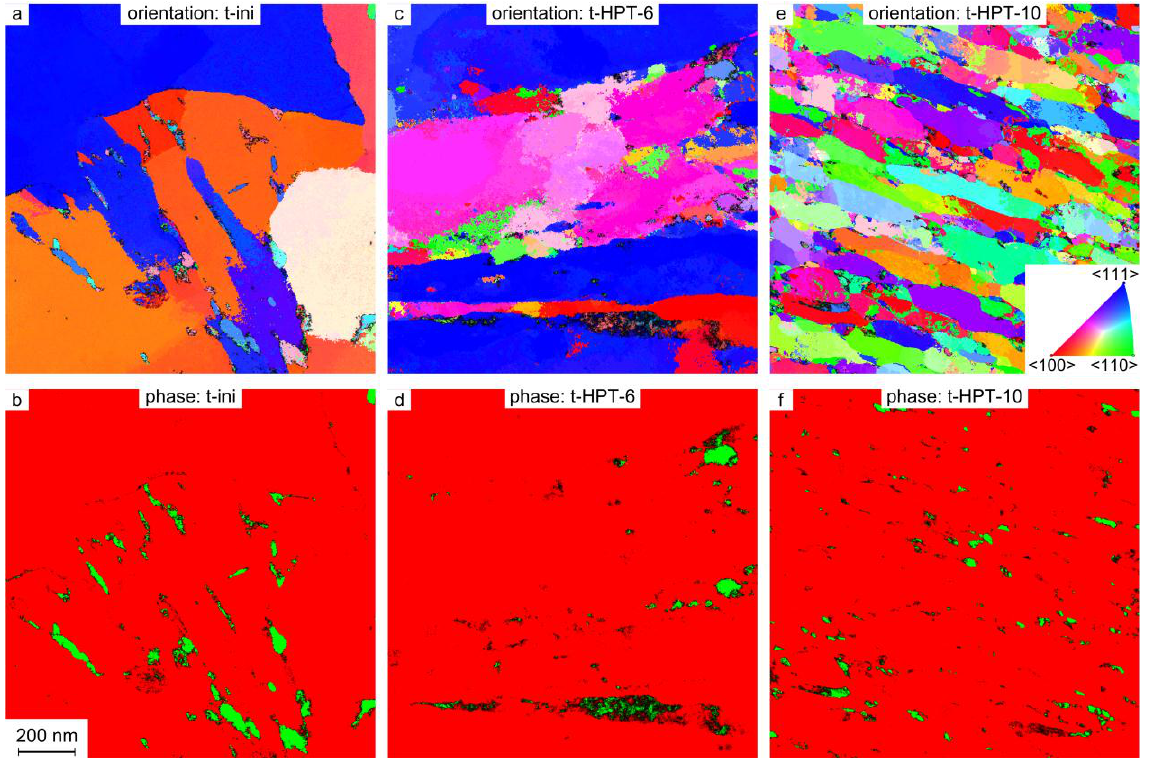
Figure 4. Orientation ( a , c , e ) and phase ( b , d , f ) maps (ACOM-TEM) overlaid with the reliability of the tempered microstructures ( a , b ), after 6 ( c , d ) and 10 HPT rotations ( e , f ) all prior to the fatigue tests. The color code of the orientation maps is given in ( e ). The projection direction is normal to the paper plane. The Fe phase is given in red and green represents the carbide phase. The reliability is given in black for both types of maps.